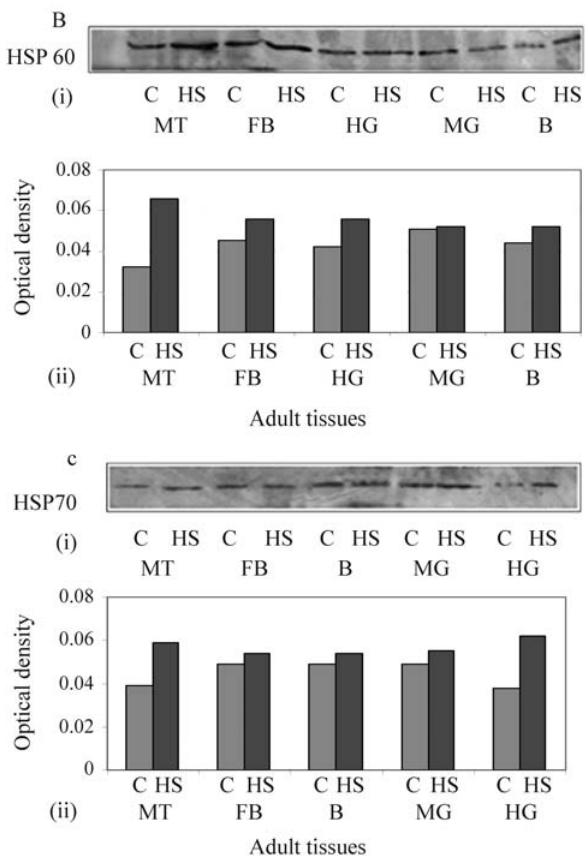
Figure 2B - (i). Western blot showing the HSP60 expression pattern in Malpighian tubule (MT), fat body (FB), hindgut (HF), midgut (mg) and brain (B) somatic tissues of adult M. domestica (N = 15) at control (C, 25 °C) and heat shock temperature (HS, 42 °C). (ii) Histogram showing densitometric optical density (OD) measurement of band intensity in the corresponding western blot lanes shown in (i) above. Figure 2C - (i). Western blot showing the HSP70 expression pattern in Malpighian tubule (MT), fat body (FB), brain (B), midgut (mg) and hindgut (HG) tissues of adult M. domestica (N = 15) at control (C, 25 °C) and heat shock temperature (HS, 42 °C). (ii) Histogram showing densito- metric optical density (OD) measurement of band intensity in the corre- sponding western blot lanes shown in (i) above.